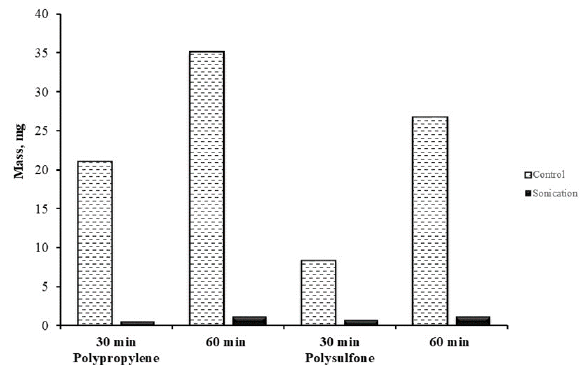
Figure 6. Weight measurements of calcium carbonate deposits with and without ultrasound application.